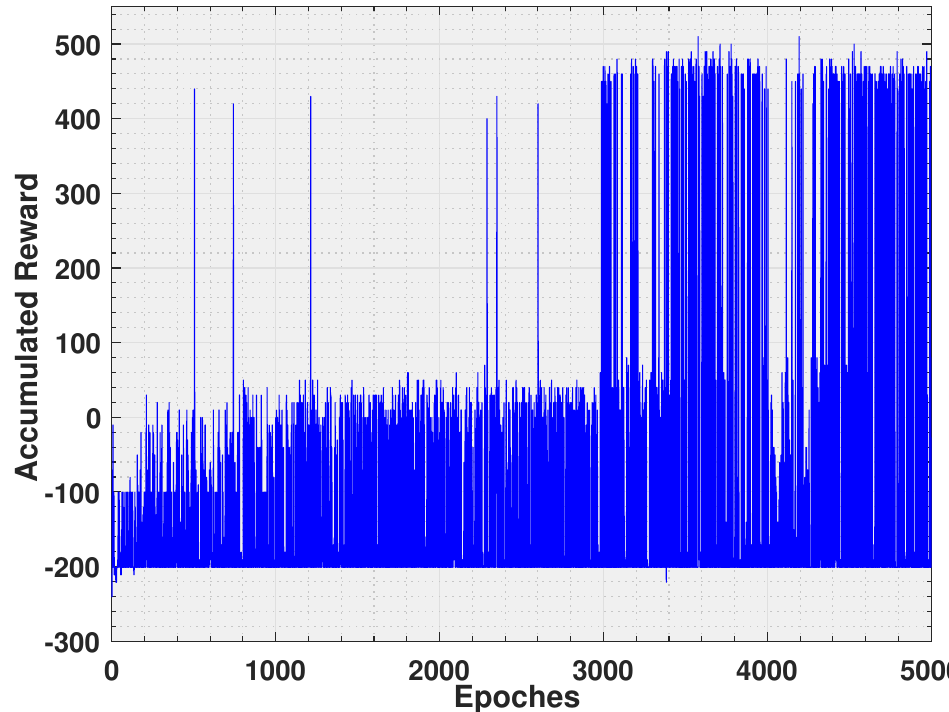
Figure 15. Accumulated reward per training epoch for decision making model